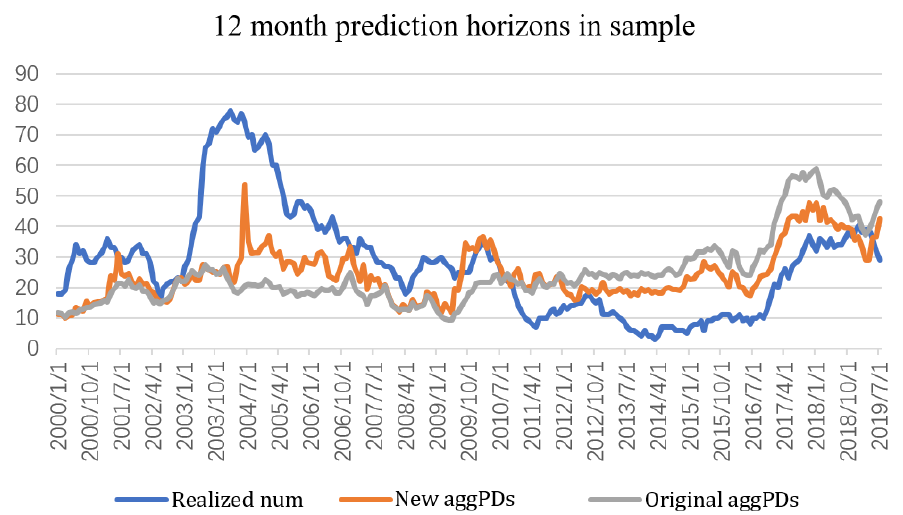
Figure 3. This figure shows a comparison of the realized number of defaults, original aggregated accumulated PDs, and new aggregated accumulated PDs for a 12-month prediction horizon in the sample.